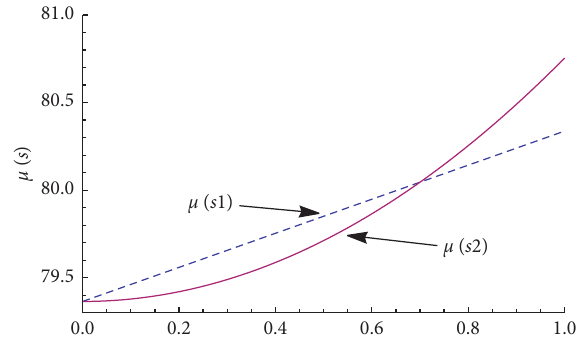
Figure 3: The evolutionary trend of government environmental governance efforts μ ( s ) under the influencing